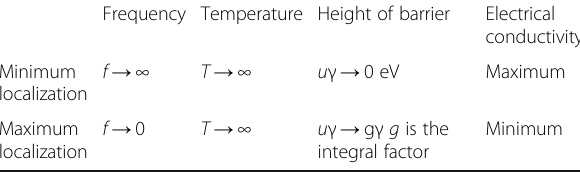
Frequency Temperature Height of